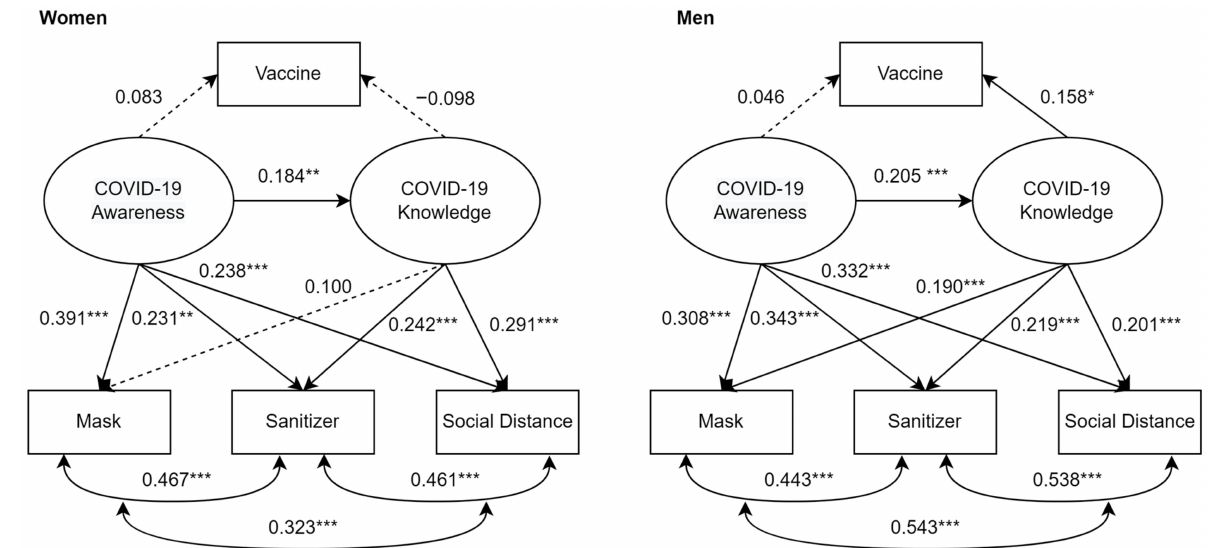
Figure 2. The final multigroup SEM model (unstandardized). Note: * p < 0.05, ** p < 0.01, *** p < 0.001. Statistically insignificant results are presented as dash arrows.